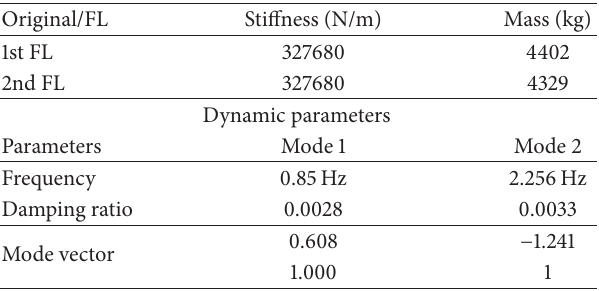
Table 1: Natural frequency, damping ratio, and mass of test